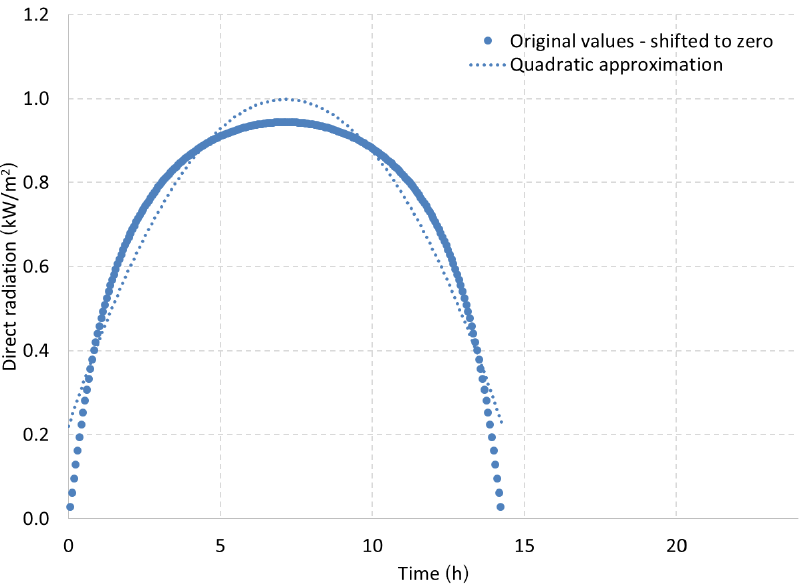
Figure 3. Insolation waveform (and its quadratic approximation) shifted to the beginning of the coordinate